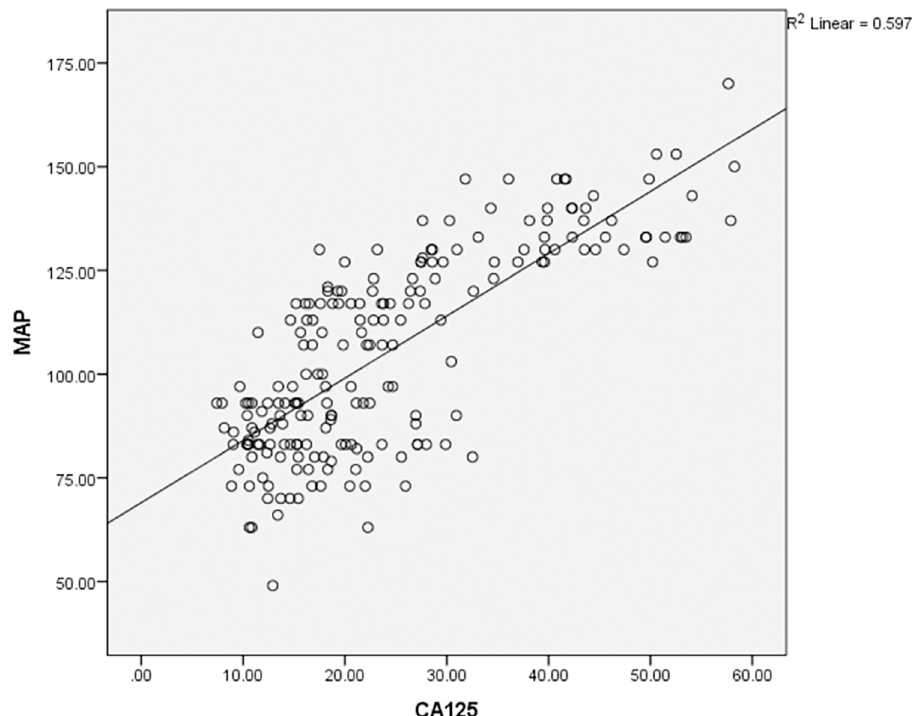
Fig 1. Correlation of cancer antigen 125 (CA-125) and mean arterial pressure (MAP) in the study groups (mild and severe preeclampsia). MAP = 40 + 2.333 CA-125 (regression equation according to coefficients table) (t = 17.11, p < 0.001).